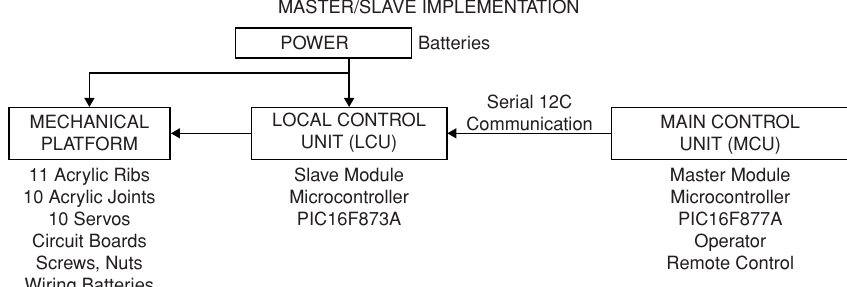
Figure 2 Block diagram of the master/slave